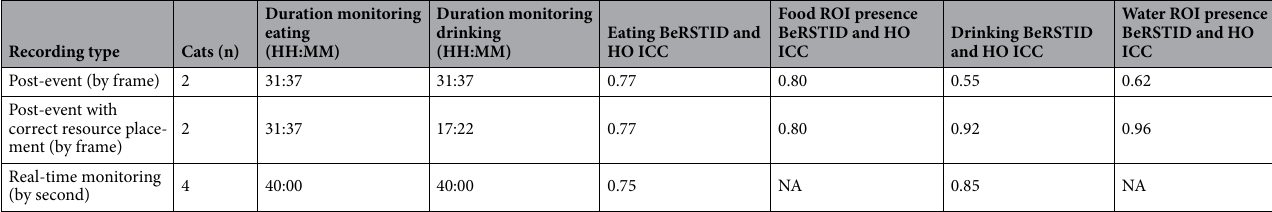
Table 1. Intraclass correlation coefficients (ICC) for observer agreement between a human observer (HO) recorded behaviour and computer vision marker detection output. Region of interest (ROI) presence indicates detection or HO recorded presence within a defined ROI. All p values <